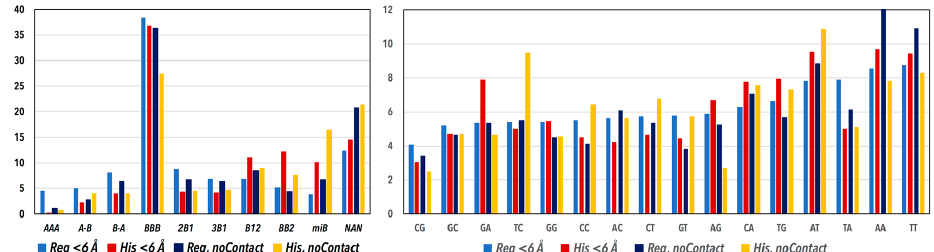
Figure 3. Histograms of the percentages of the CANA letters and 16 dinucleotide sequences in the four discussed groups of dinucleotides: Regulatory < 6 Å, Histones < 6 Å, Regulatory no contact, and Histones no contact. The sequence data are ordered from low to high fractions for the Regulatory < 6 Å group.